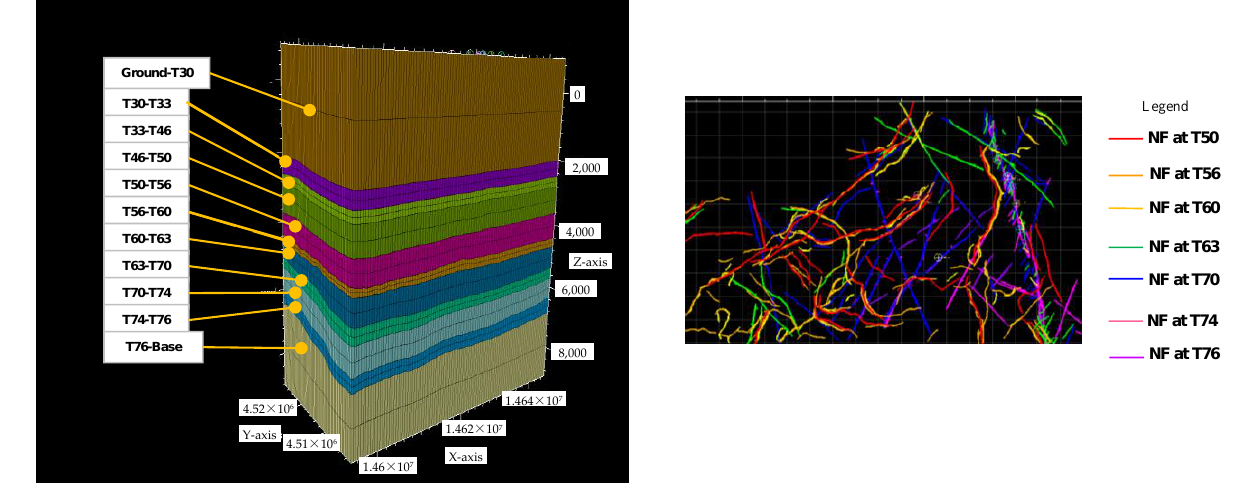
Figure 2. 3D geological model of target formations at Fuman Oilfield ( left ) and the overlapped plane view of natural fractures ( right ) at each interface.